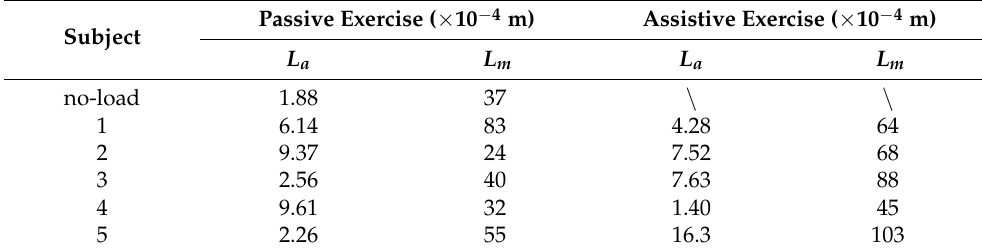
Table 1. Subjects’ deviation errors in two exercise